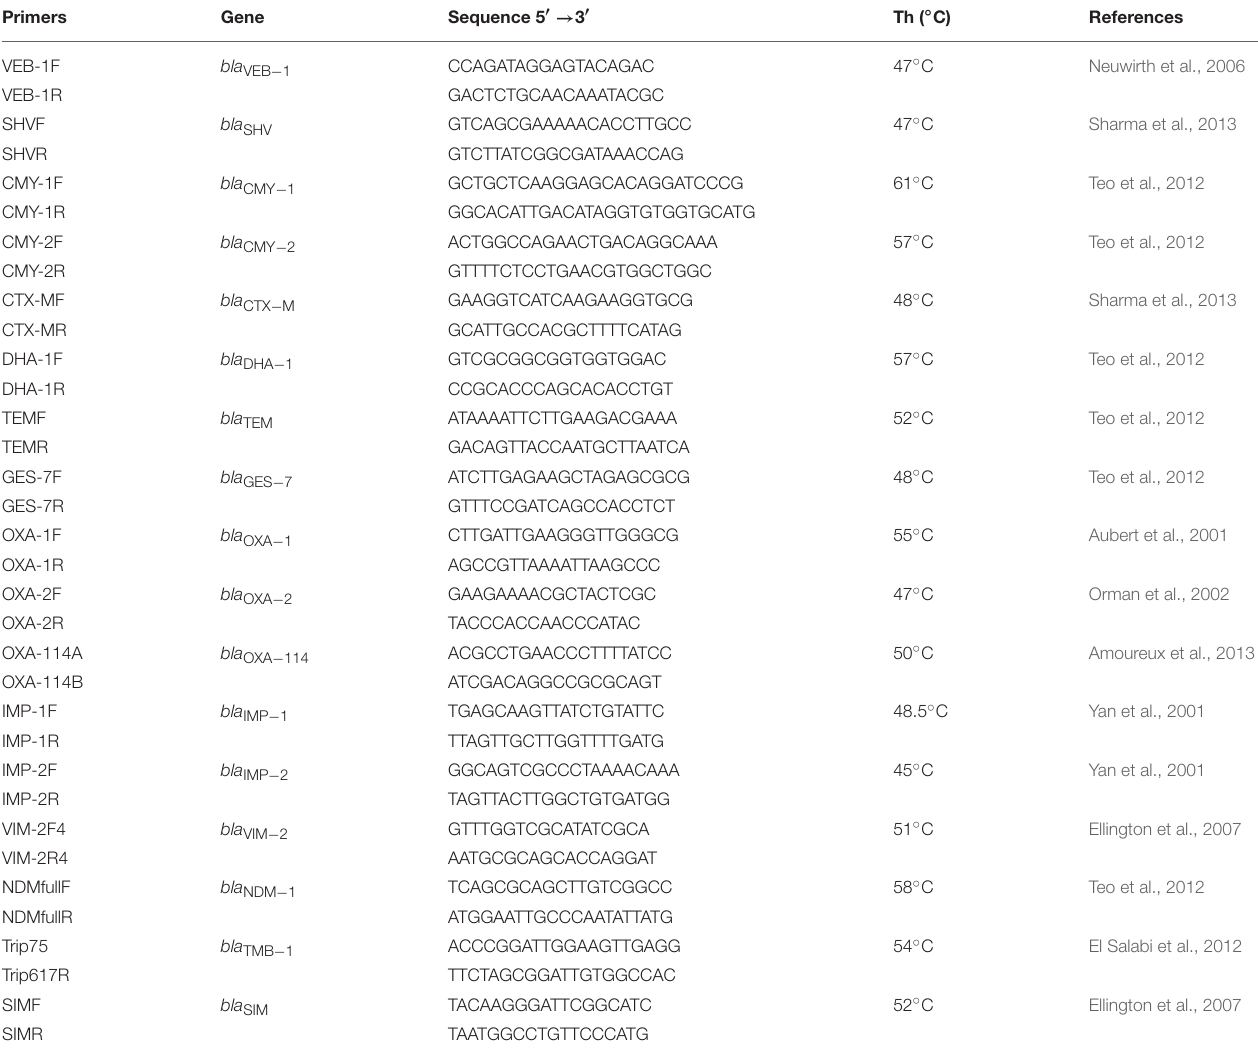
TABLE 3 | List of primers used in this